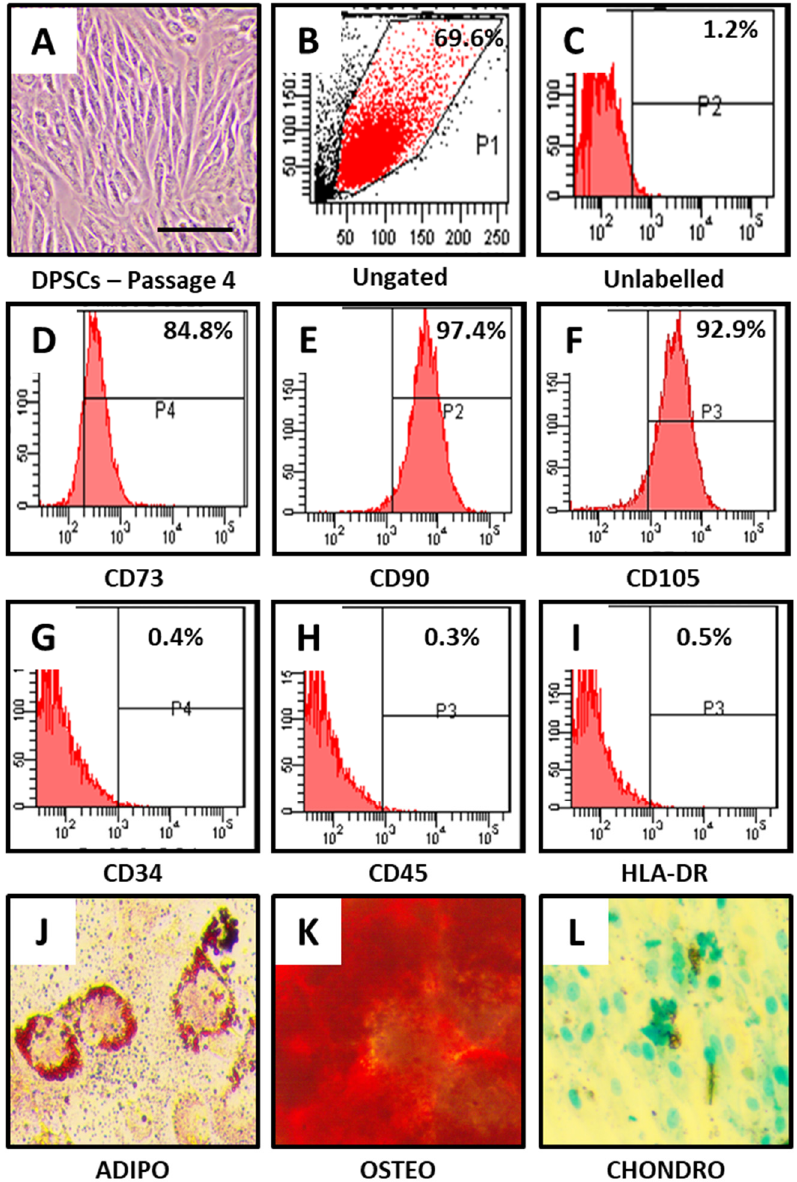
Figure 1. Characterization of DPSCs for mesenchymal stem cell (MSC) markers and trilineage differentiation. ( A ) Photomicrograph of DPSCs at passage 4. ( B – I ) DPSCs were checked for MSC- specific positive markers CD73, CD90, and CD105; and MSC-specific negative markers CD34, CD45, and HLA-DR. ( J – L ) DPSCs were differentiated into adipocytes, osteoblasts, and chondrocytes. Scale bar = 100 µ m. DPSCs: dental pulp stem cells, ADIPO: adipogenic differentiation, OSTEO: osteogenic differentiation, CHONDRO: chondrogenic differentiation.